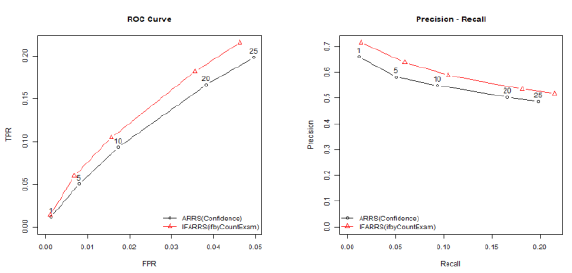
Figure 5. The ROC and Precision/recall Curve of ARRS and IFARRS models on Movielens dataset.